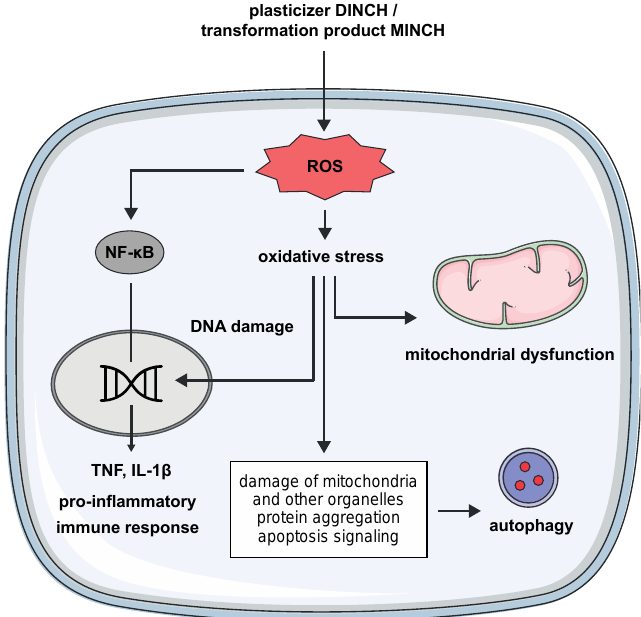
Figure 5. Proposed mode of action of DINCH and MINCH in THP-1 macrophages. ROS levels were increased, leading to activation of NF- κ B and subsequent release of TNF and IL1- β , thereby inducing a pro-inflammatory immune response. Increased ROS levels led to oxidative stress, resulting in DNA damage and mitochondrial dysfunction. As a response to the cellular stress and associated apoptosis, autophagy was activated.